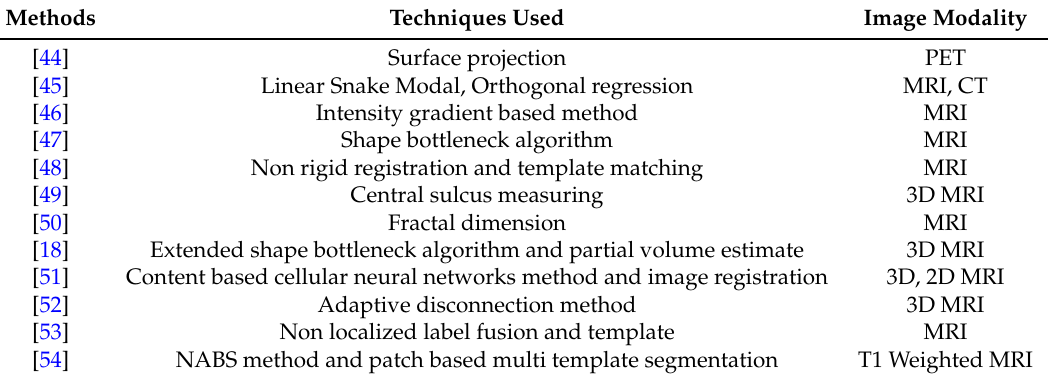
Table 2. Summary of the other methods and approaches for brain symmetric and asymmetric analysis.